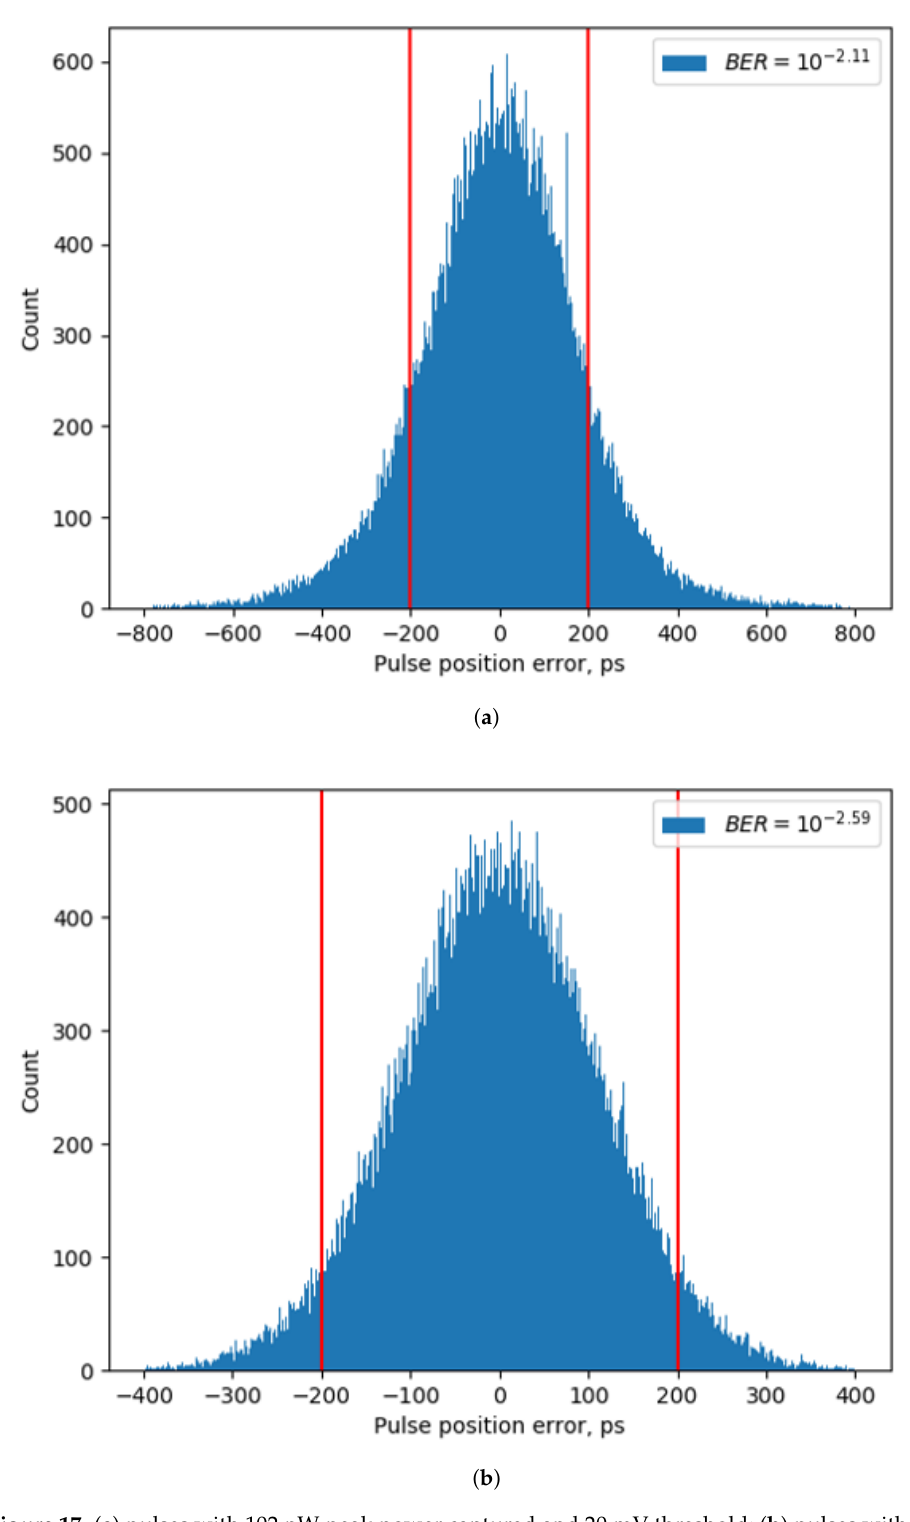
Figure 17. ( a ) pulses with 102 nW peak power captured and 20 mV threshold; ( b ) pulses with 176 nW peak power captured and 28 mV threshold. Histograms of the time stamps and pulse position error at the best thresholds for 102 nW and 176 nW. A slot width of 400 ps is shown on each histogram with vertical red lines, where time stamps located outside these lines are bit